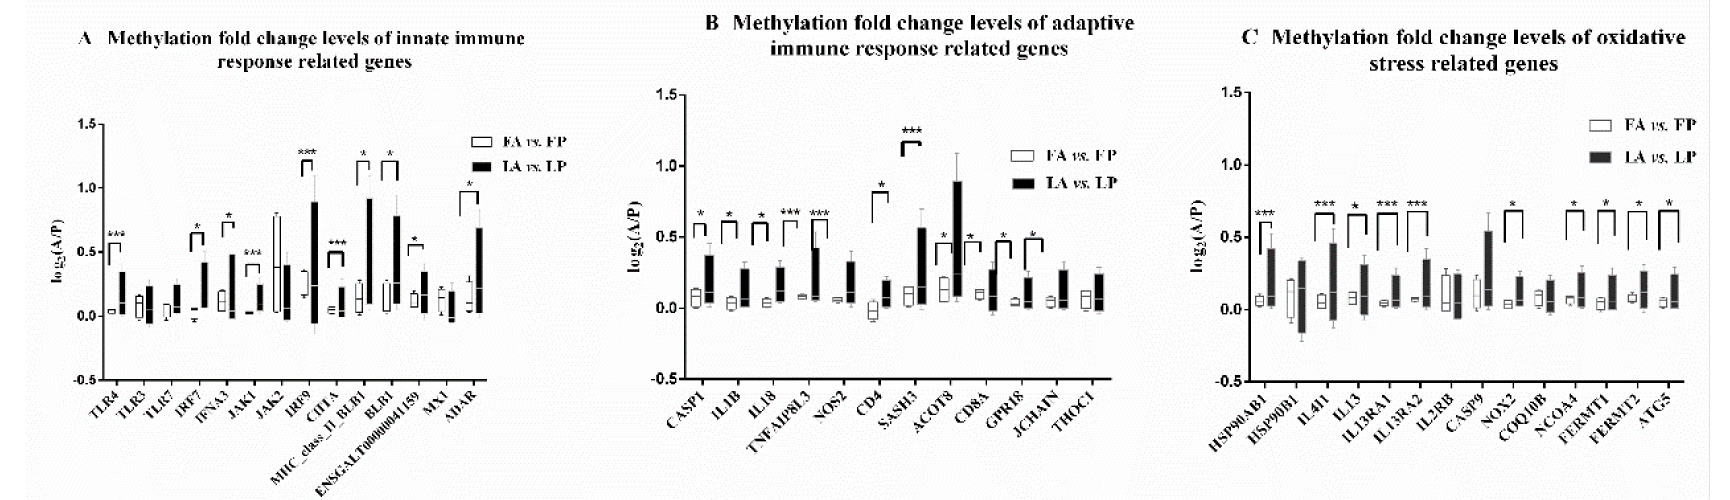
Figure 2. Gene methylation fold change levels of immune response related genes. The variance of log 2 (gene methylation ratios of individuals with AIV inoculation / gene methylation ratios of individuals challenged with PBS) were measured as the gene methylation fold change level. F-tests were used to compare gene methylation fold change levels in the Fayoumi and Leghorn breeds, * indicates a significance level of p = 0.01–0.05, *** indicates a significance level of p < 0.01. A,B,C represented innate immune response, adaptive immune response, and oxidative stress related pathways,